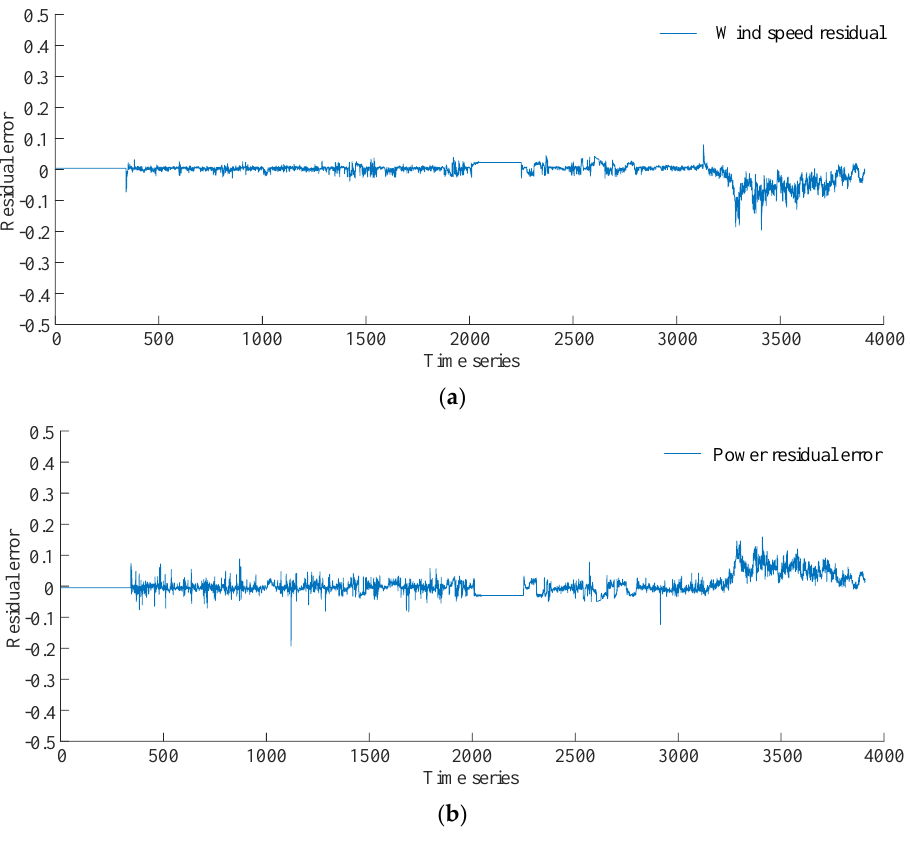
Figure 9. Test set reconstruction error. ( a ) Fixed threshold. ( b ) Adaptive threshold based on sliding window.